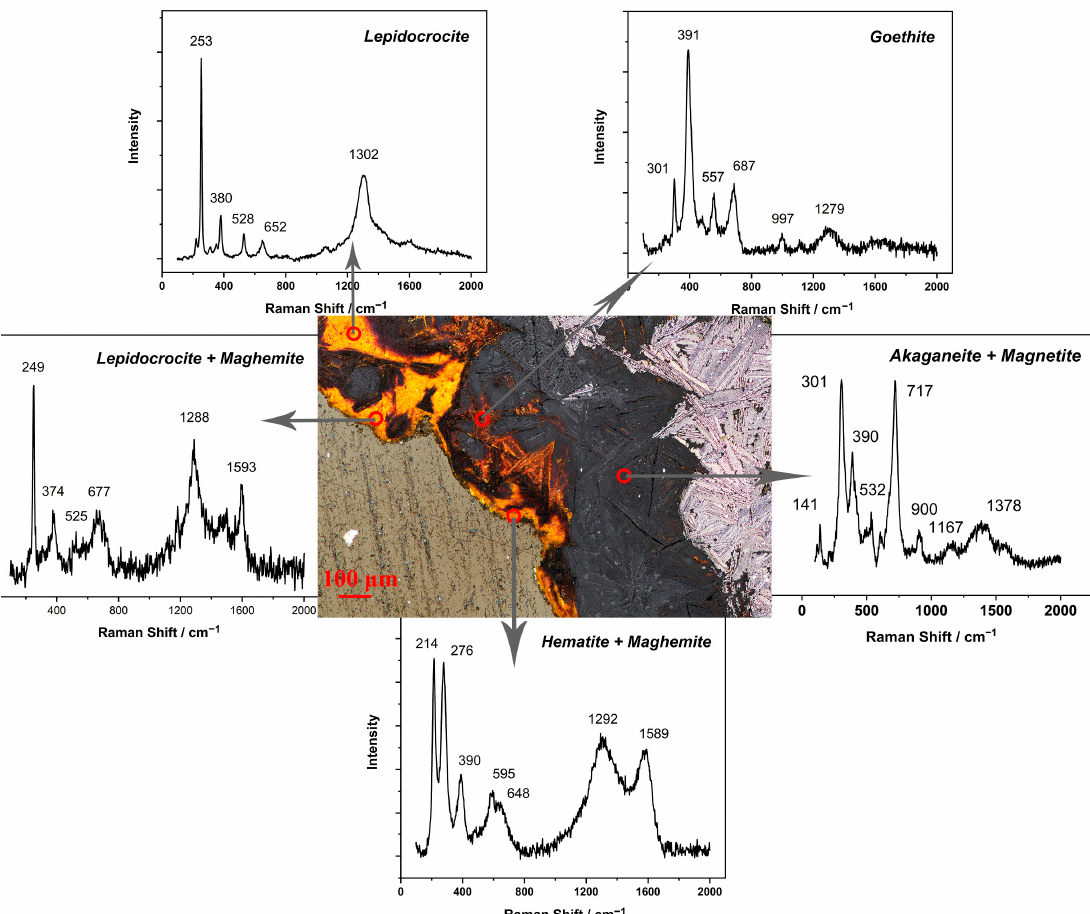
Figure 8. Raman spectra of rust layer B.